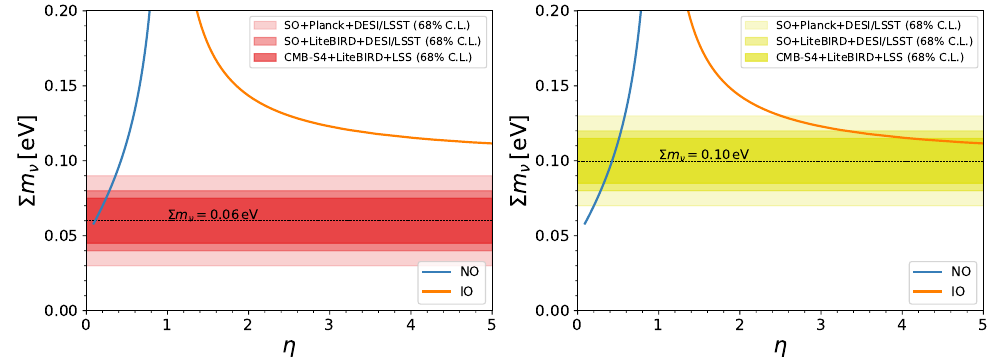
Figure 4 . Left: sum of neutrino masses as a function of the parameter (cid:17) (solid curves) in eqs. (3.10), given constraints from oscillation experiments, for normal (blue curve) and inverted (orange curve). The three increasingly darker red bands show the 68% credible interval for P m (cid:23) from future experiments given P m (cid:23) = 0 : 06 eV, corresponding to the minimal possible mass for NO, given the results from oscillation experiments. In particular, from the outermost band proceeding to the innermost, we show the expected sensitivity from: Simons Observatory combined with the Planck estimate of (cid:28) and either DESI-BAO or cluster masses calibrated with LSST weak lens- ing ( (cid:27) ( P m (cid:23) ) = 0 : 030 eV), Simons Observatory combined with the LiteBIRD cosmic-variance- limited estimate of (cid:28) and either DESI-BAO or cluster masses calibrated with LSST weak lensing ( (cid:27) ( P m (cid:23) ) = 0 : 020 eV), CMB-S4 combined with the LiteBIRD cosmic-variance-limited estimate of (cid:28) and DESI-BAO ( (cid:27) ( P m (cid:23) ) = 0 : 015 eV). Right: same as left panel, but now the three in- creasingly darker yellow bands show the 68% credible interval for P m (cid:23) from future experiments given P m (cid:23) = 0 : 10 eV, corresponding to the minimal possible mass for IO, given the results from oscillation